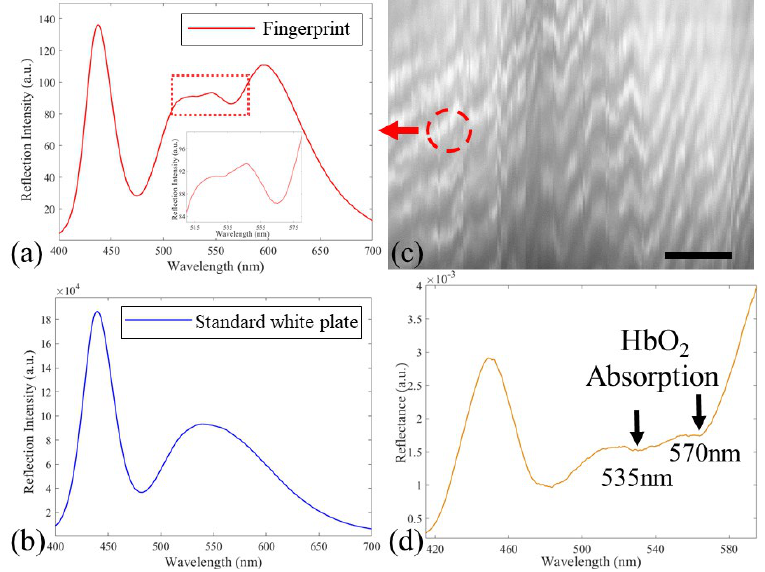
Figure 4. Experimental results for the hyperspectral detection of a human fingerprint under the reflection mode. ( a ) The reflection spectrum of the fingerprint. ( b ) The reflection spectrum of the standard white plate. ( c ) The hyperspectral image of the tested fingerprint. Scale bar: 500 μm. ( d ) The reflectance spectrum calculated by Equation (2) and the data in ( a ) and ( b ).